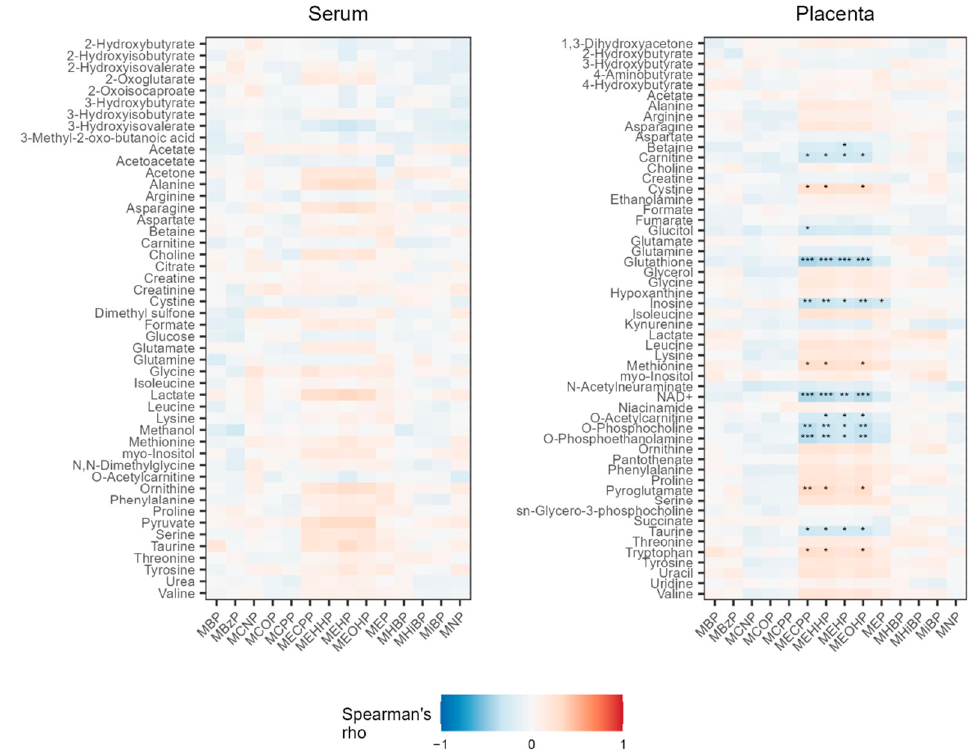
Figure 1. Spearman correlations between phthalate metabolites and serum metabolites ( left ) and placenta metabolites ( right ). Positive associations (red) identify metabolites where higher urinary phthalate metabolite concentrations correlated with higher metabolite concentrations, while negative associations (blue) identify metabolites where higher urinary phthalate metabolite concentrations correlated with lower metabolite concentrations. Metabolites that remained significant after FDR correction are marked with stars. For FDR-corrected p < 0.001, ***; p < 0.01, **; and p < 0.05,